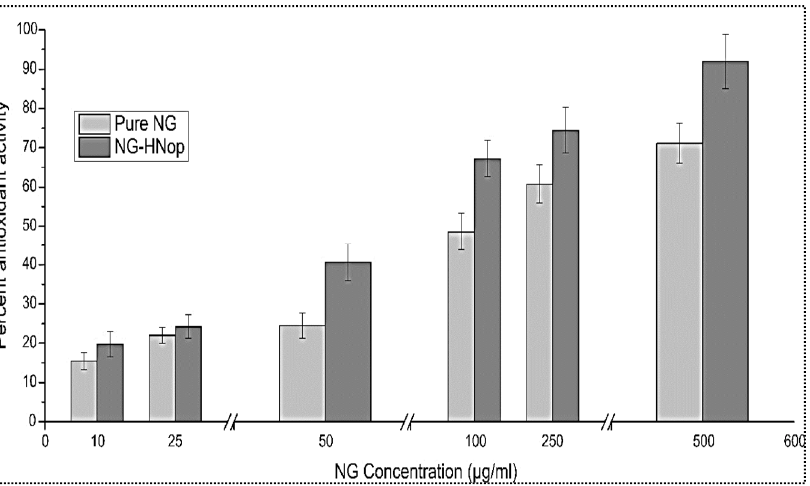
Figure 6. In vitro antioxidant activity of pure Naringin (NG) and Naringin hybrid nanoparticles (NG-HNop). The study was performed in triplicate and the data are shown as mean ± SD.